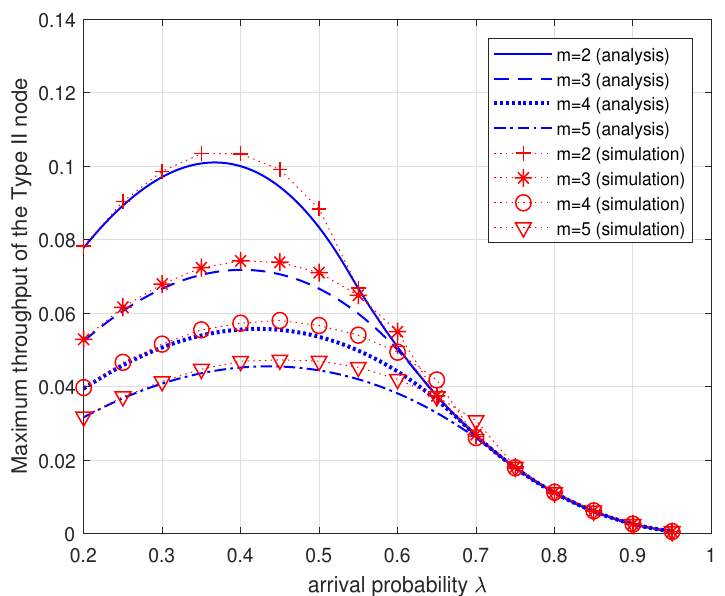
Figure 7. Maximum throughput T ∗ of the Type II node (given by the Corollary 1) versus the arrival II probability λ for different energy cost of transmission m .